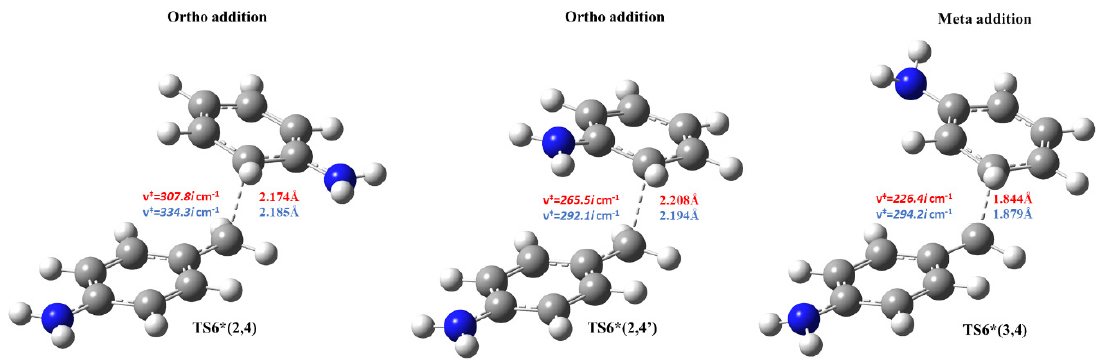
Figure 4. Transition state structures (obtained at B3LYP/6-31G(d) level of theory) for 4,4’-MDA isomer formation (Critical distance are also given for both condensed phases).